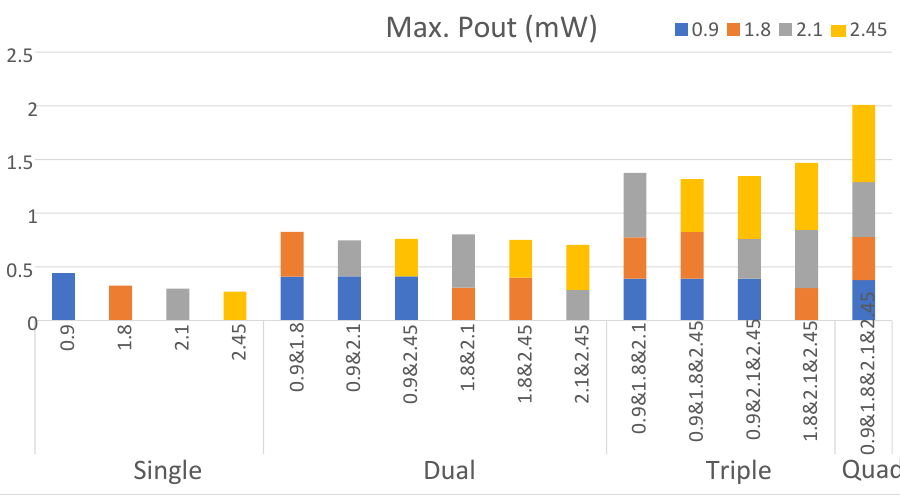
Figure 22. A chart for the output power for single band, dual band, triple band and quad band.